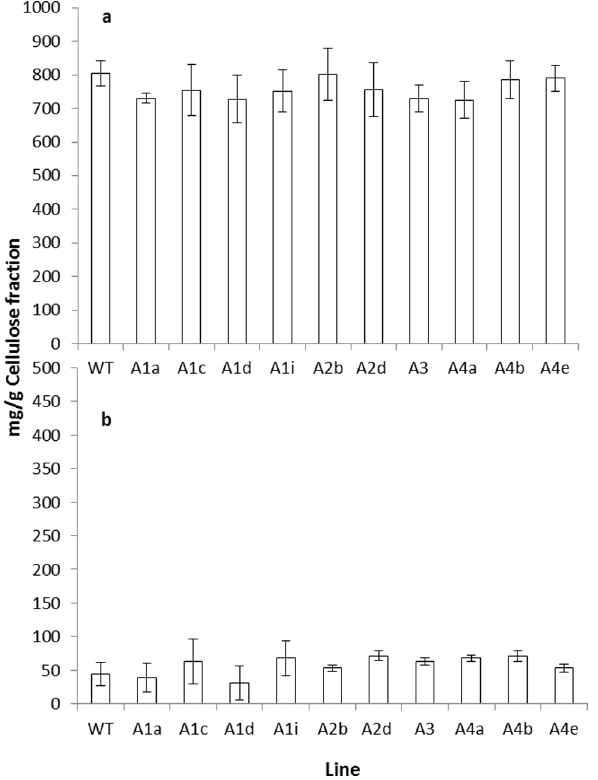
Figure 4. Sugar composition of the cellulose rich fraction of wild type and rabA knockout lines. The cellulose rich fraction was subjected to hydrolysis and monomer sugar composition in terms of (A) Glucose or (B) Xylose assessed by HPAEC. Statistical values are as follows; glucose p=0.036 (d.f,32 v.r, 2.49); xylose p=0.115 (d.f,32